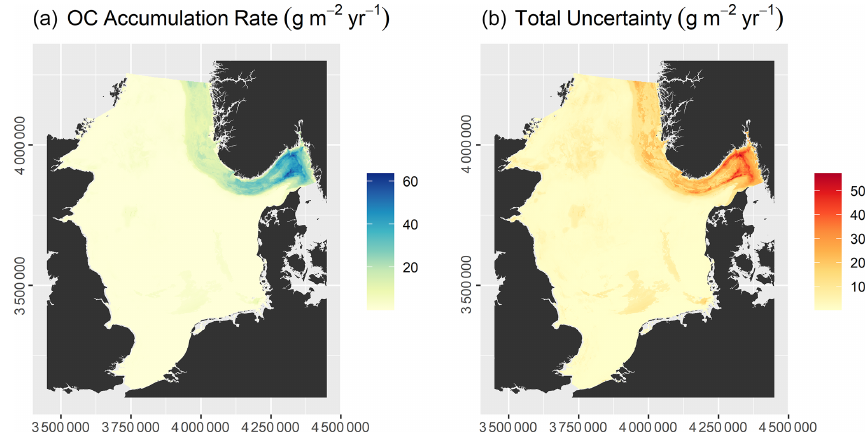
Figure 6. Calculated OC accumulation rate (a) and associated uncertainty (b)